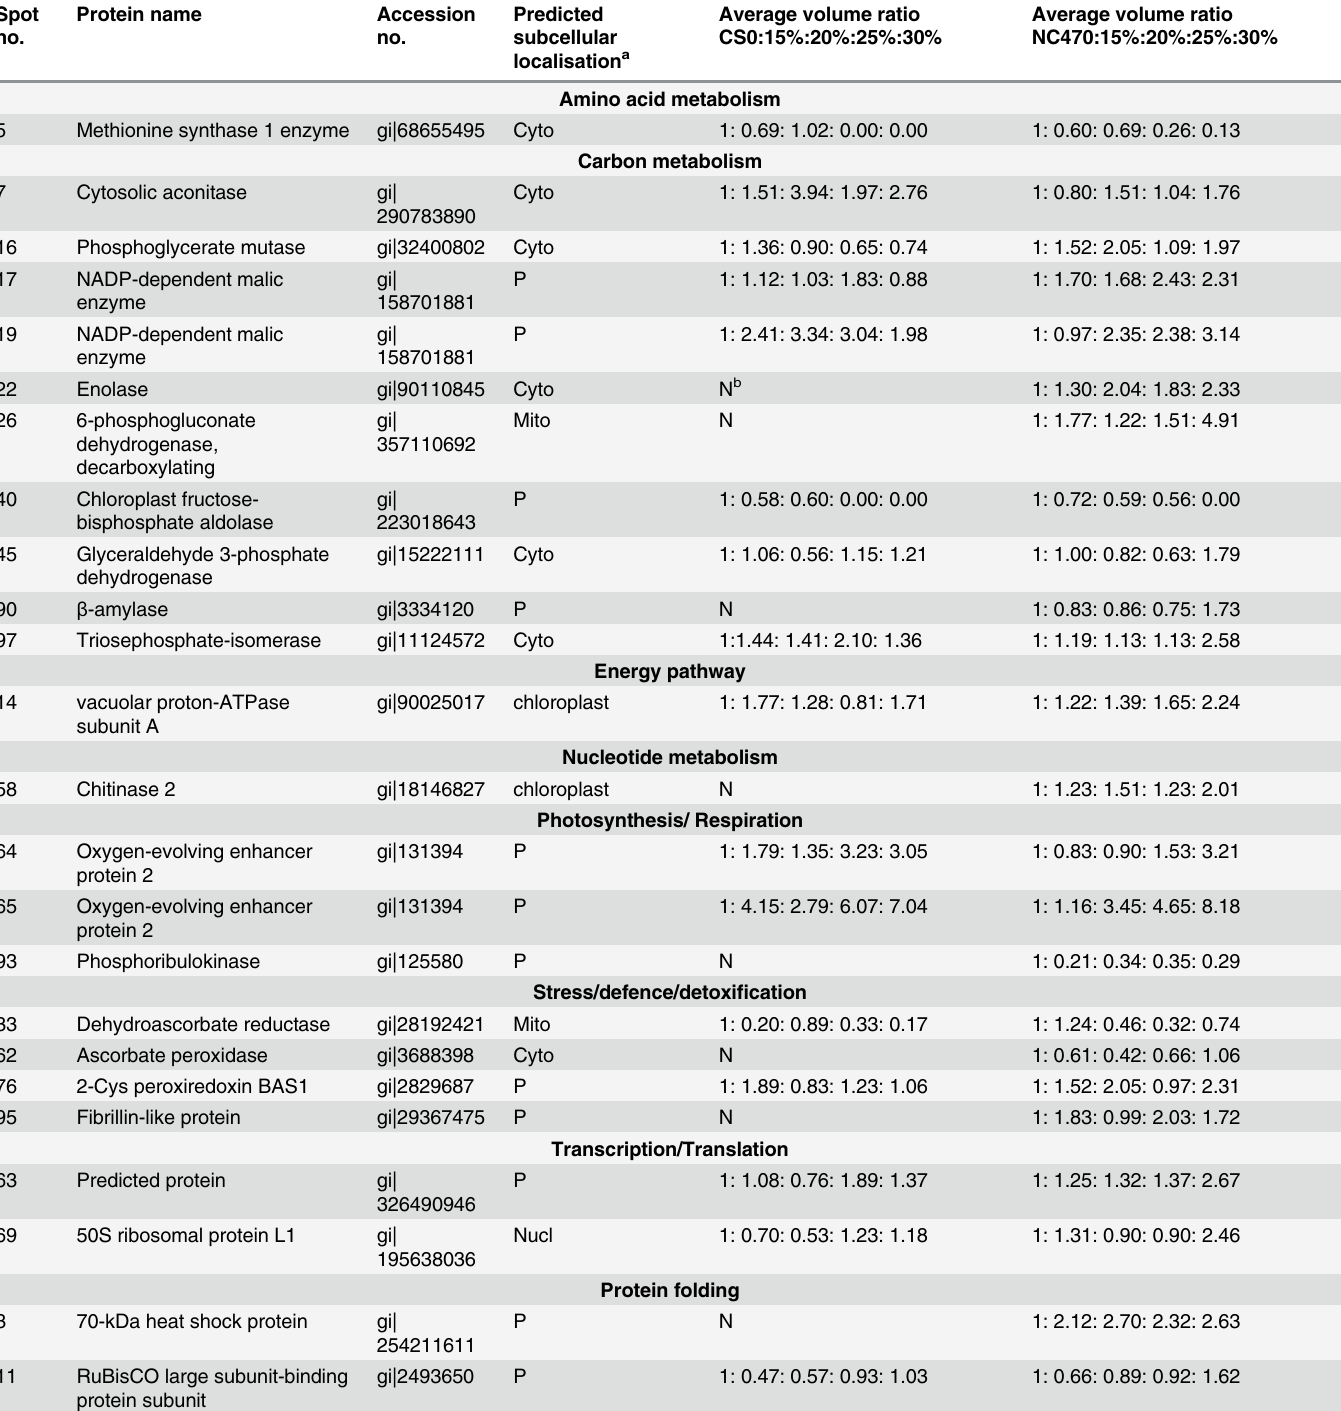
Table 1. Comparison of some important DAPs in seedling leaves of NC47 and CS. Spot